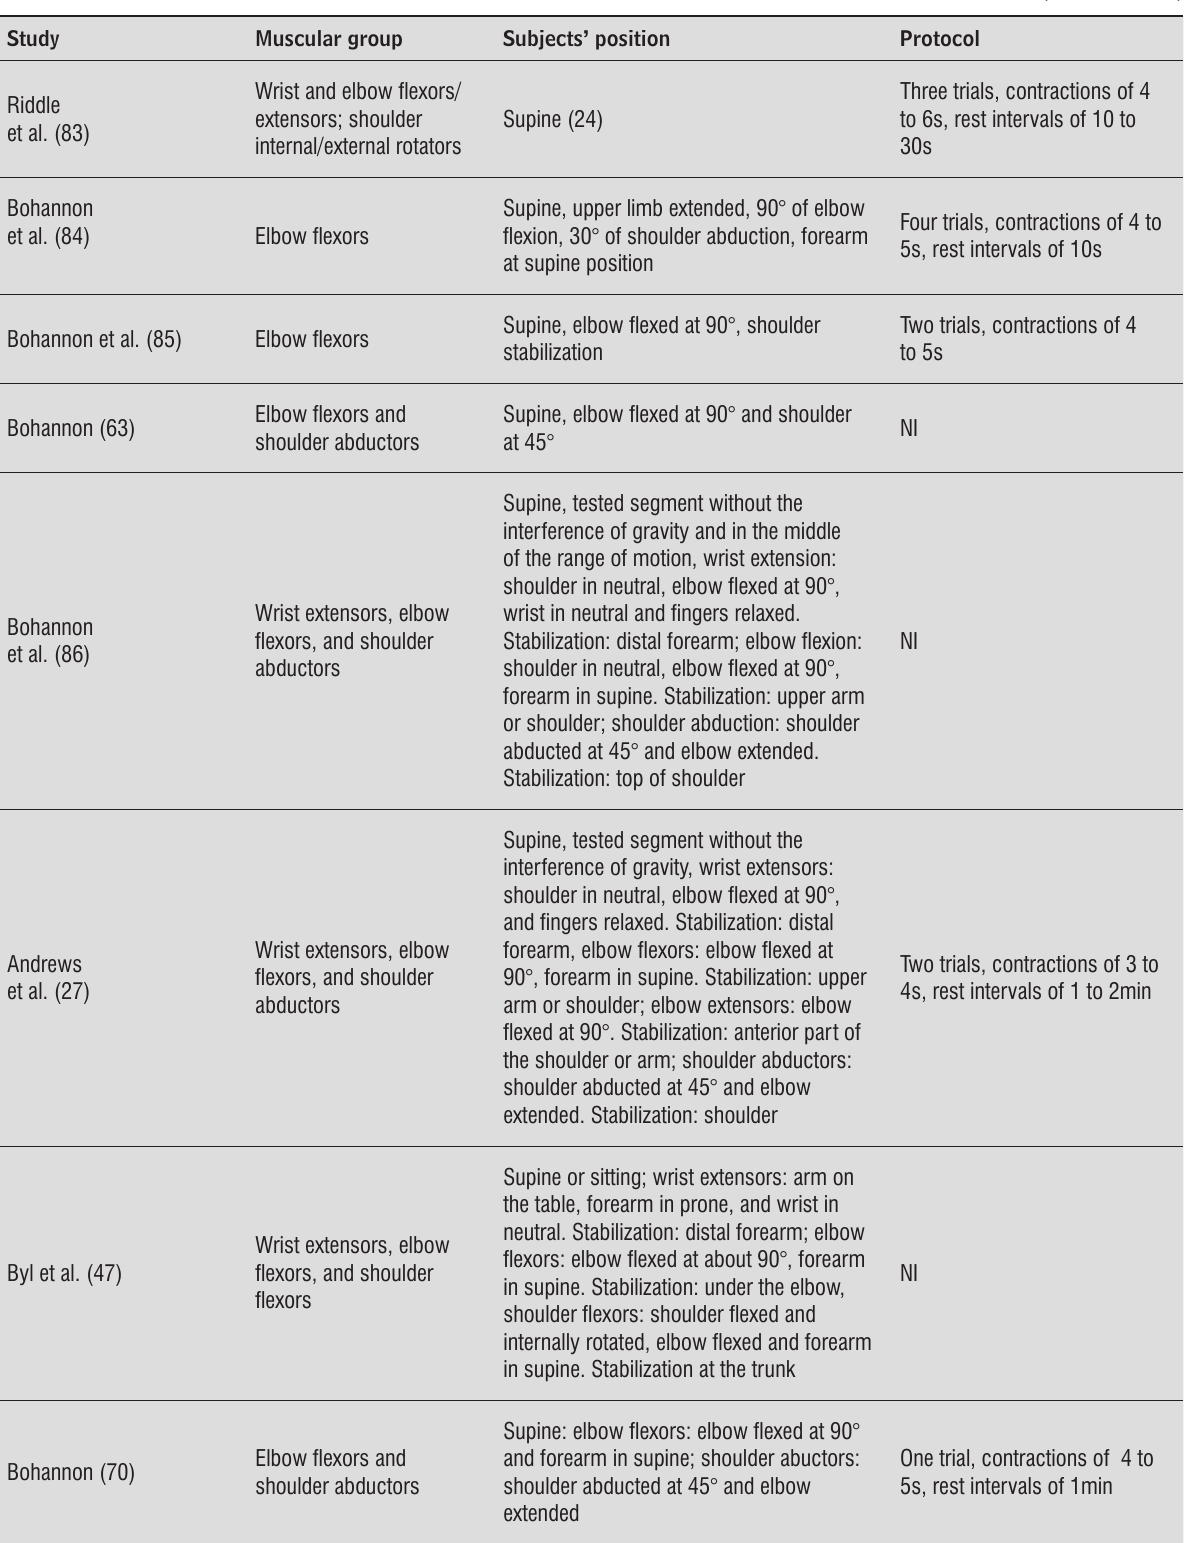
Table 4 - Data extraction of the 14 studies which assessed the upper limb strength in subjects with stroke with portable dynamometers and provided information regarding the subject’s positioning or the data collection